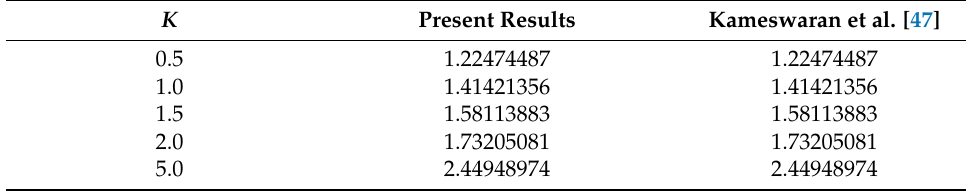
Table 2. Values of − f (cid:48)(cid:48) ( 0 ) for different values of K when ϕ hnf = S = β = 0, and λ = 1. K Present Results